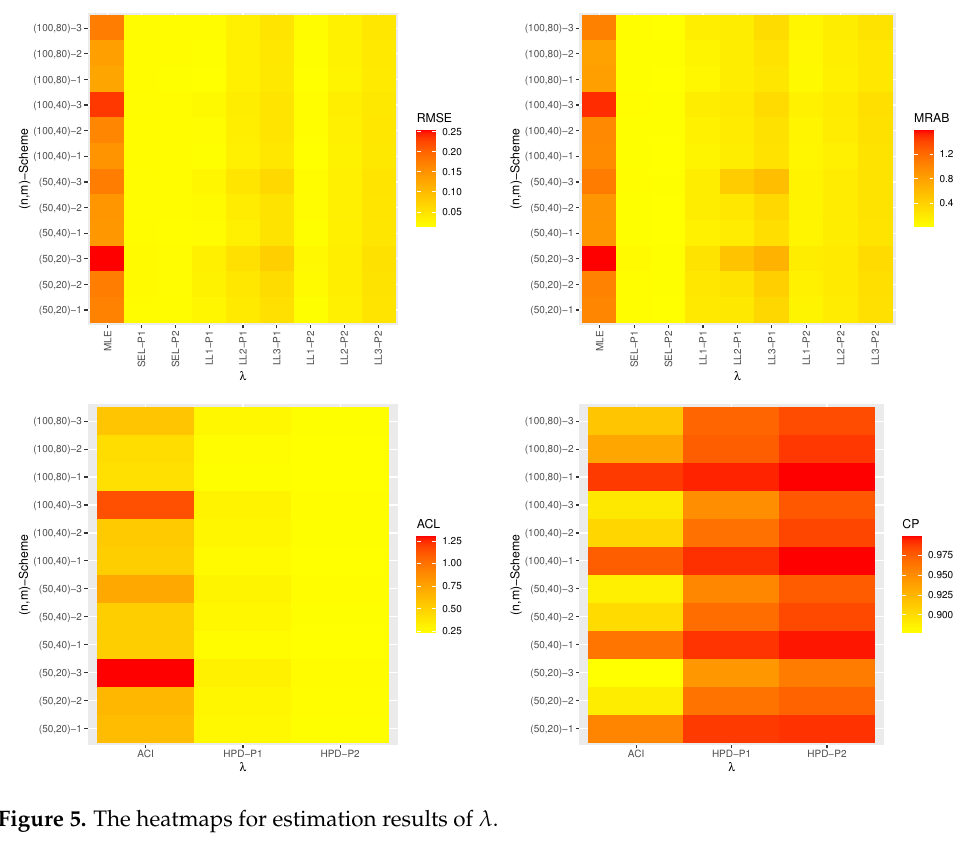
Figure 5. The heatmaps for estimation results of λ .